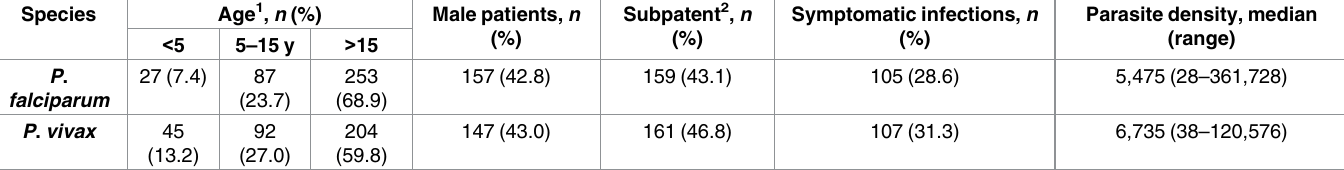
Table 1. Demographic information.